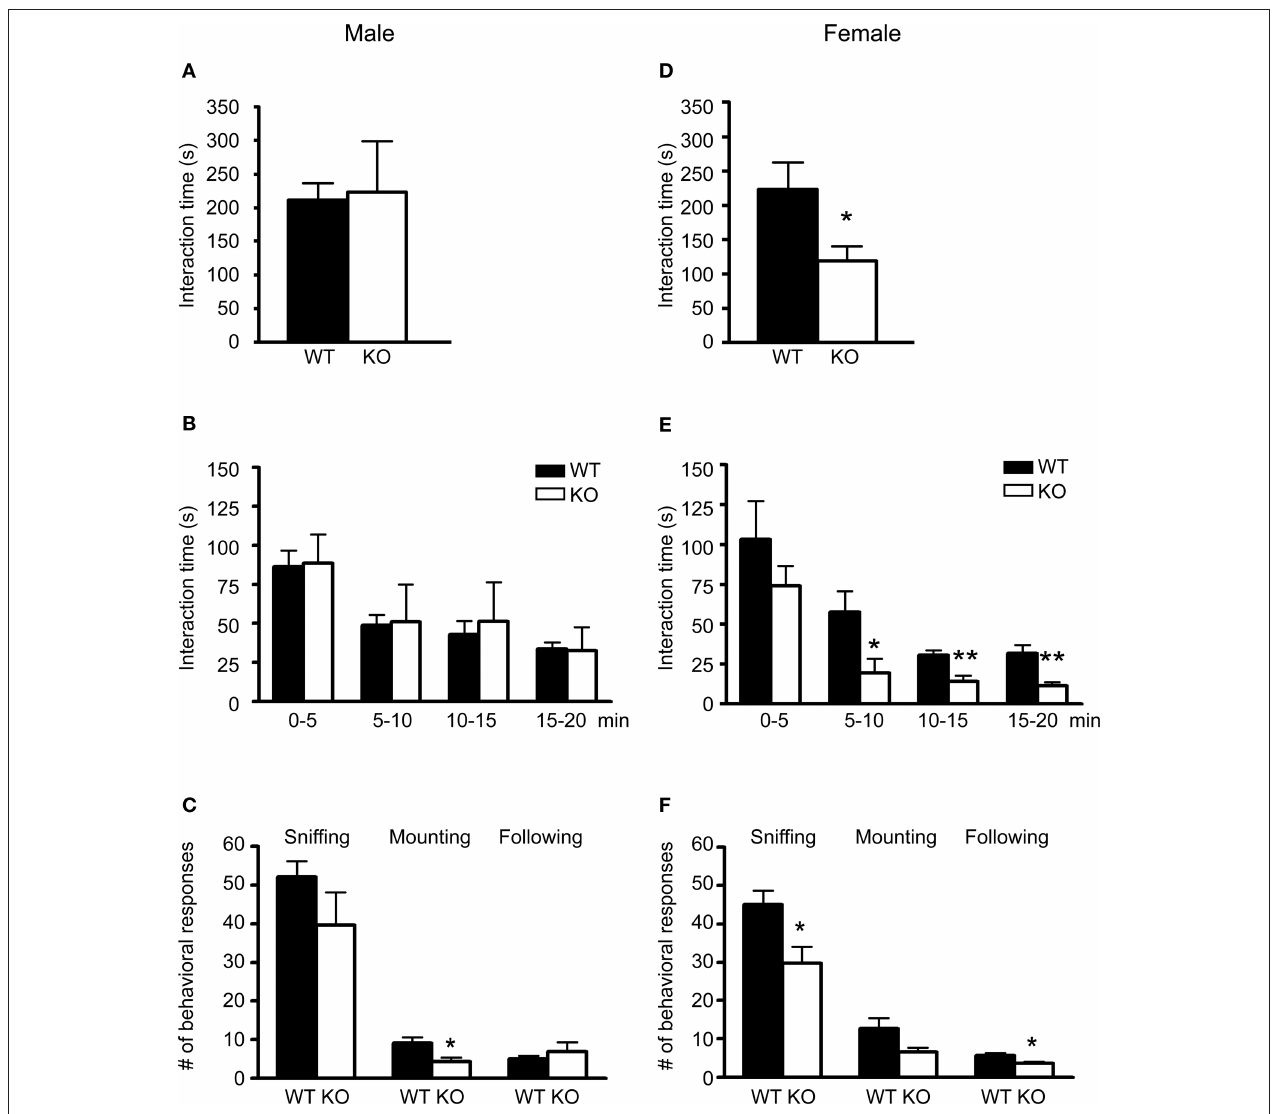
5-HT knockout mice spent less time in reciprocal social interaction than pairs of 3A wildtype mice. (e) Although both groups showed a similar decrease in reciprocal social interactions over time, female 5-HT knockout mice spent less time in 3A reciprocal social interaction between 5 and 20 min of testing than wildtype mice. (F) Female 5-HT knockout mice showed a lower number of sniffing and 3A following responses during the test as compared to wildtype mice. Data are expressed as the mean ± SEM (* p < 0.05; ** p <